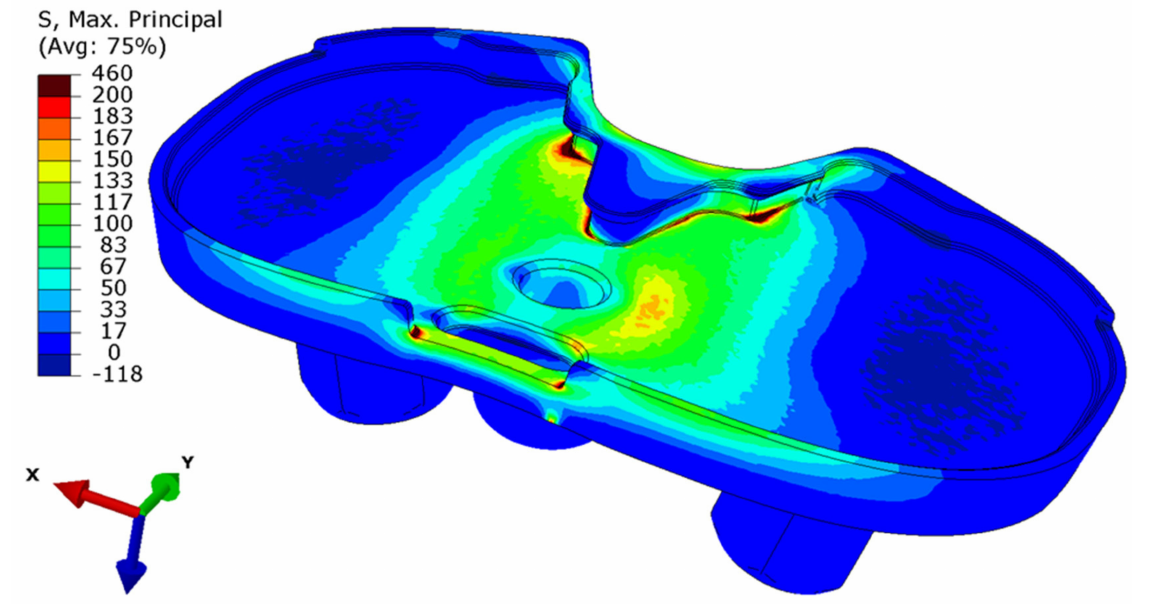
Figure 12. Distribution of maximal principal stresses (in MPa) on the surface of the medially unsup- ported tibial plate loaded by the patient’s body weight during standing on one